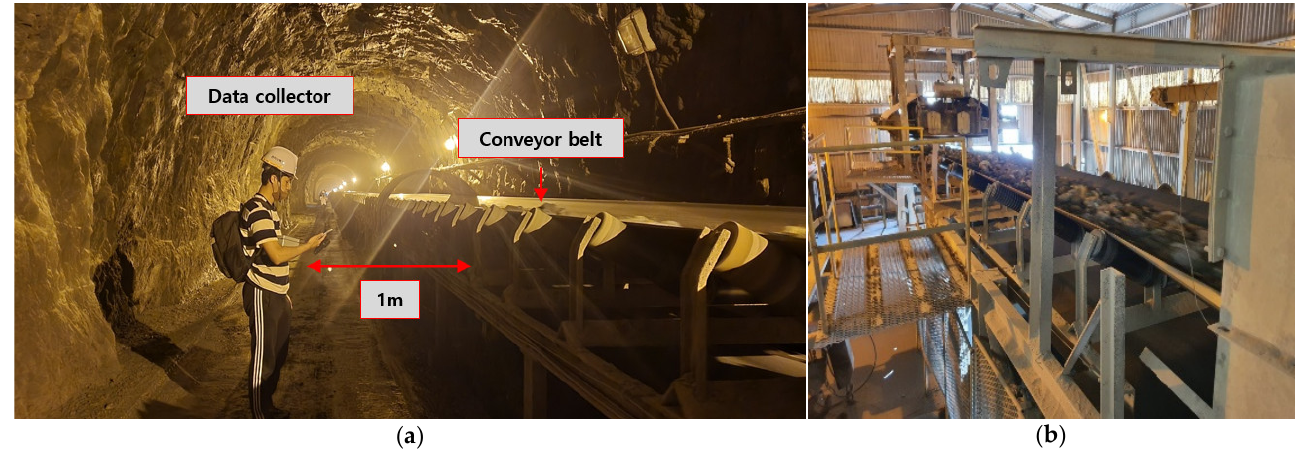
Figure 7. Conveyor belt environment, they should be listed as: ( a ) Inside the quarry tunnel; ( b ) Out- side the quarry tunnel.